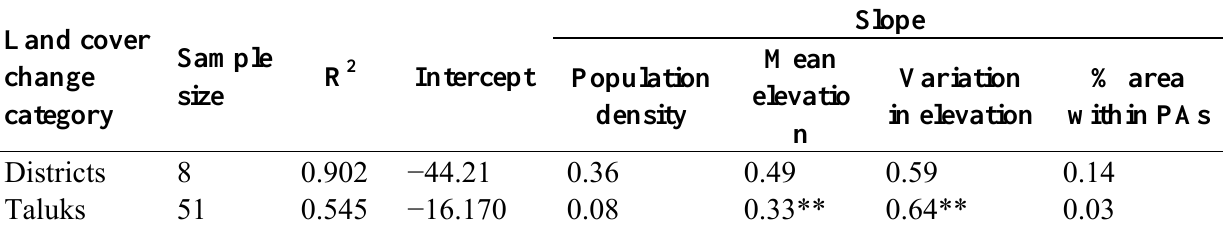
2. Nature, strength and significance of four proposed drivers of forest change—population density, average elevation, variation in elevation and percentage within PAs—on the distribution of deforestation in the study region, at the scale of districts and taluks. Results based on a linear regression analysis. Significance codes: ** p < 0.01, * p <